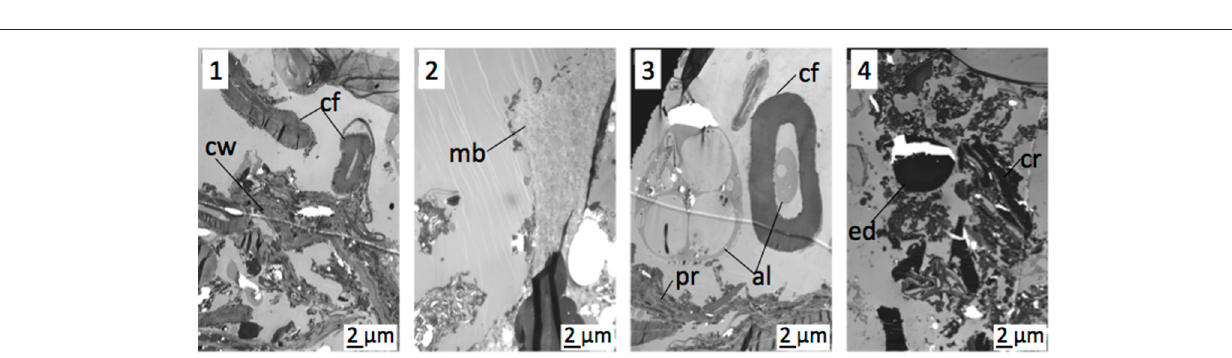
FIGURE 3 | TEM views of 2–5mm compost fractions, main organic residues (1) , with membrane structured MPS (2) , with alveolar MPs (3) or with electron-dense particle (4) . al, alveolar MPs; cf, cellulosic fiber; cr, cell residue; cw, cell wall; ed, electron-dense MPs; mb, membrane structured MPs; pr, plant